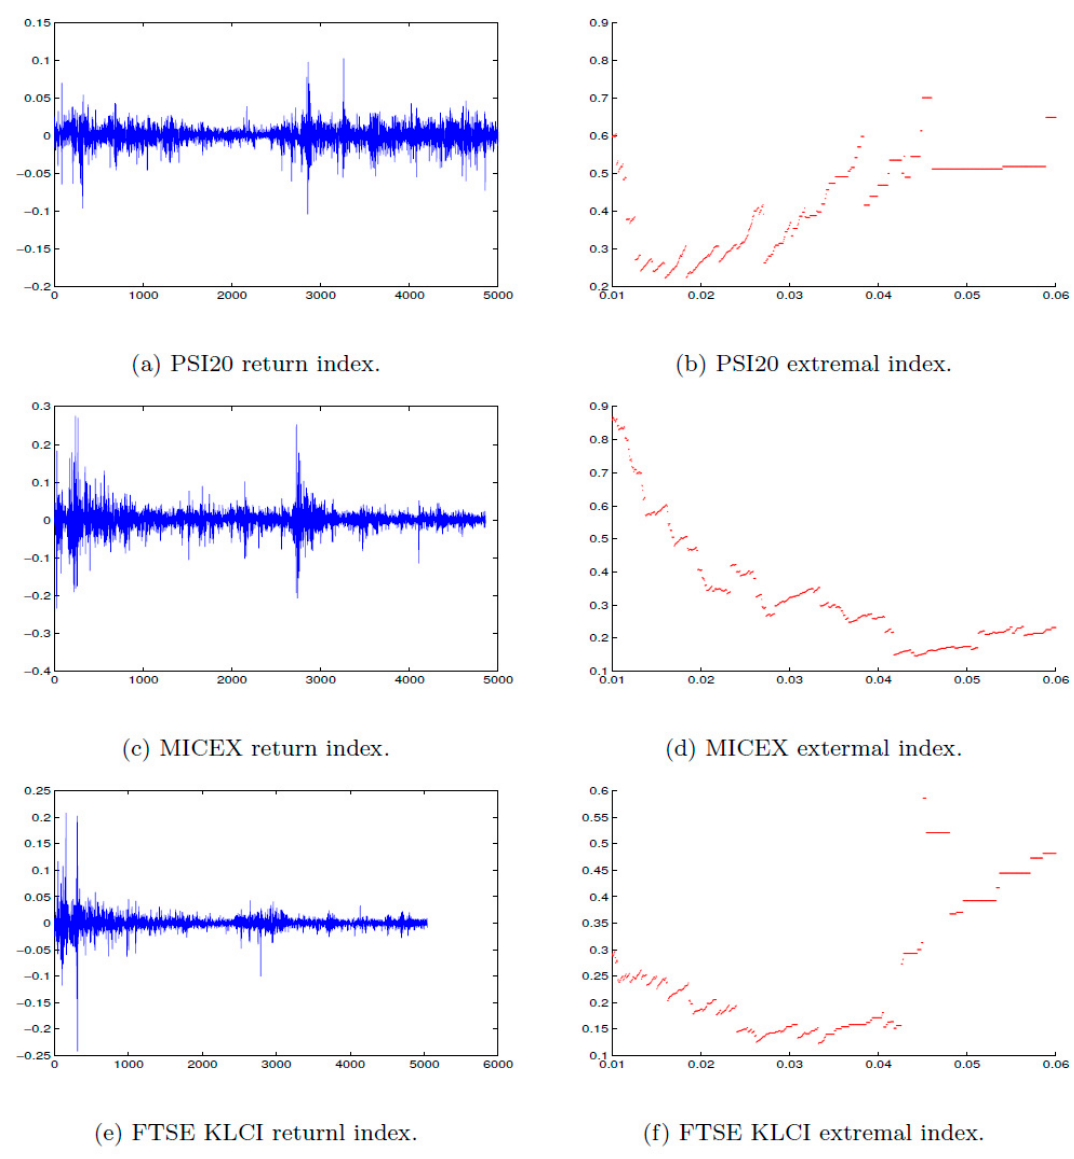
Figure 5. Daily log returns of ( a ) PSI20, ( c ) MICEX, ( e ) FTSE KLCI for the period from 1 July 1997 to 16 January 2017, that consists of an average of ( n = 5000) observations. The estimated extremal index ( b ) PSI20, ( d ) MICEX, ( f ) FTSE KLCI at a range of threshold u of ( b ) PSI20, ( d ) MICEX, ( f ) FTSE KLCI at a range of threshold u .